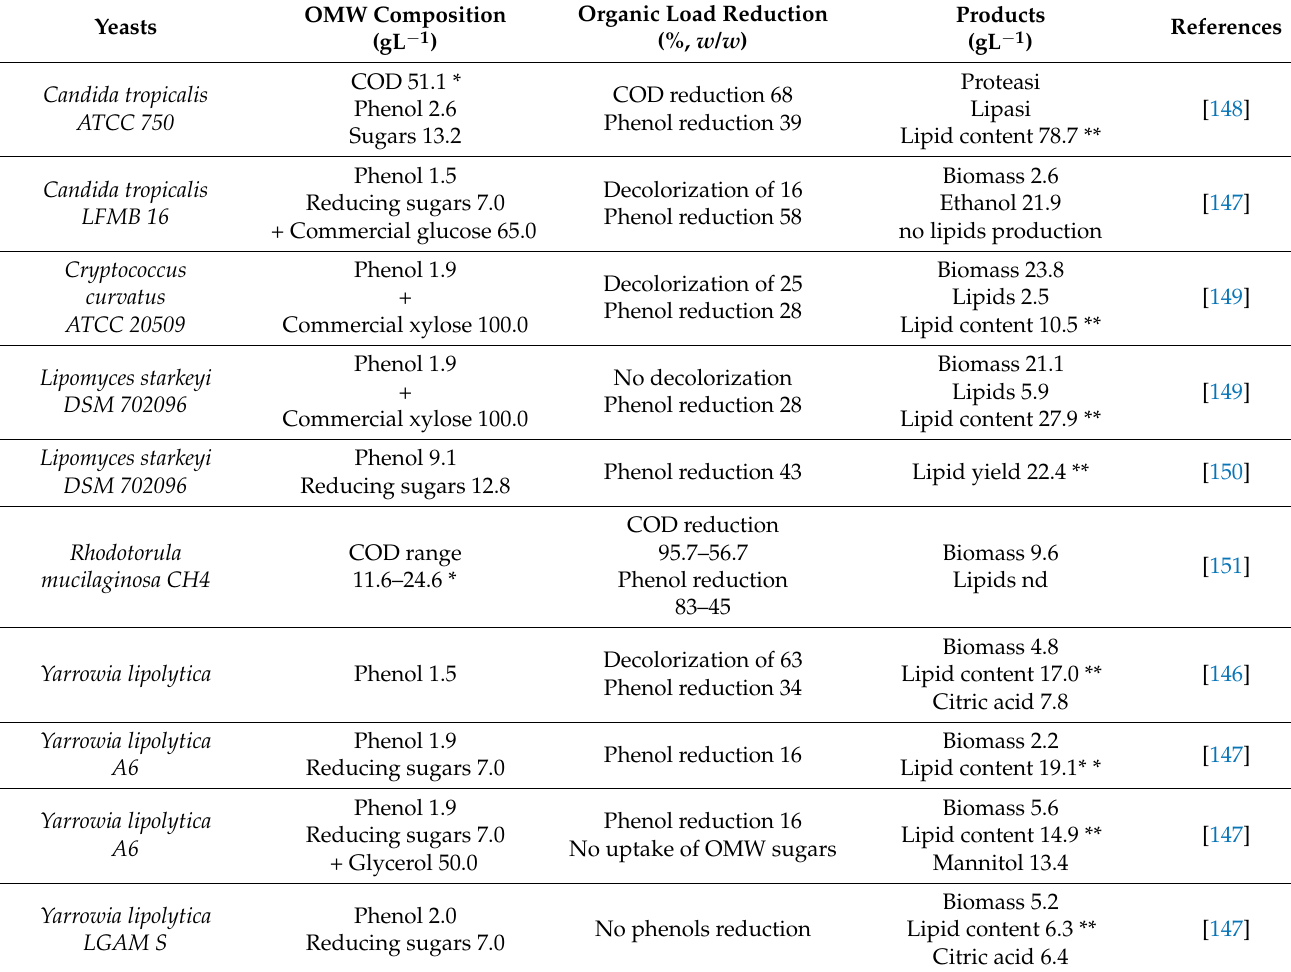
Table 3. Effect of oleaginous yeasts on OMW detoxification and product synthesis. * = mgL -1 , ** = (%, w/w